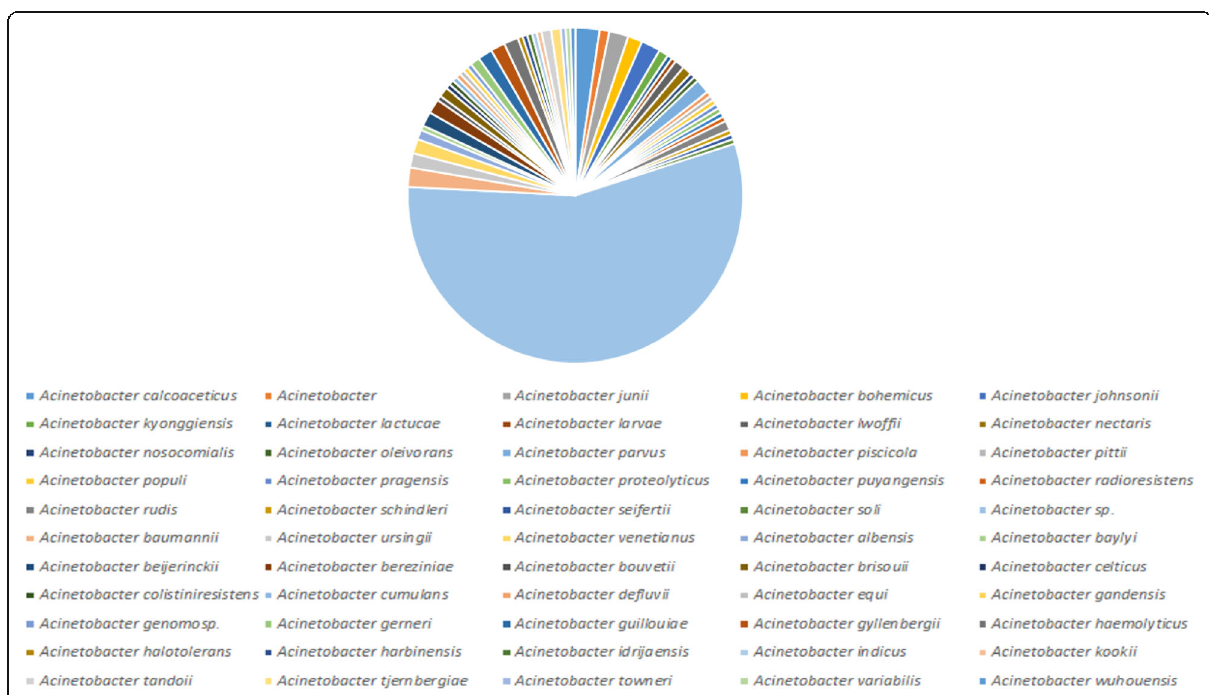
Fig. 11 Similarity pie diagram of MurG from A . baumannii and its related sequences from various Acinetobacter species obtained from iterative BLAST search